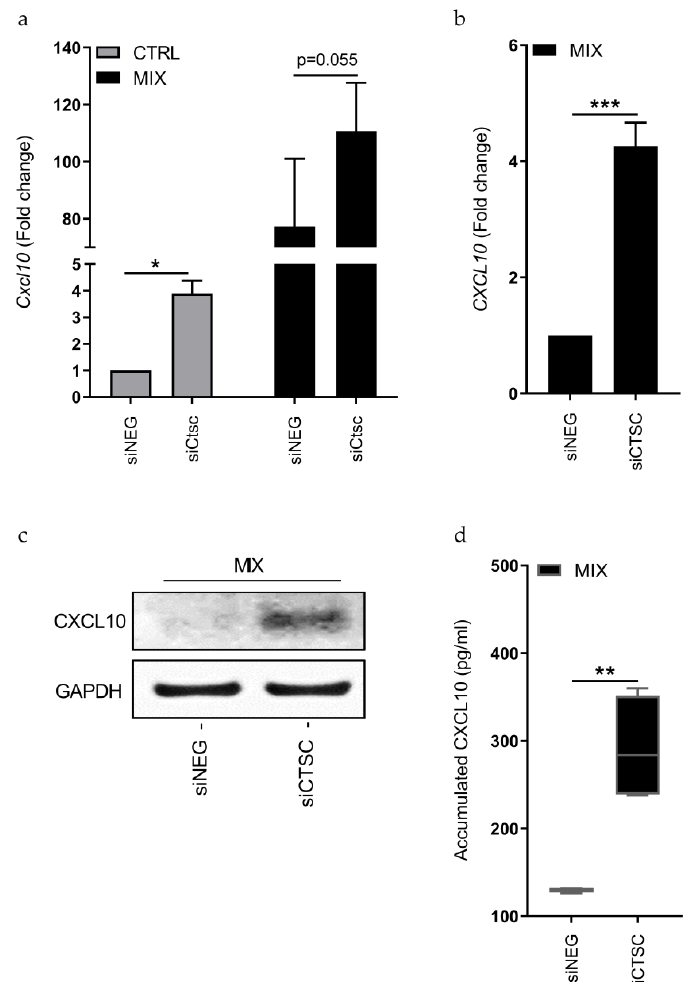
Figure 5. Knockdown of CTSC increases CXCL10 expression and secretion. ( a ) INS-1E cells were transfected with a siRNA pool against Ctsc (siCtsc) or a non-targeting negative control siRNA pool (siNEG) and left untreated (CTRL) or exposed to IL- 1β and IFN - γ for 24 h (MIX). Cxcl10 mRNA expression was analyzed using real-time qPCR with Hprt as housekeep- ing gene. ( b ) 1.1B4 cells were transfected with a siRNA pool against CTSC (siCTSC) or a non-targeting negative control siRNA pool (siNEG) and left untreated (CTRL) or exposed to IL- 1β and IFN - γ for 24 h (MIX). CXCL10 mRNA expression was analyzed using real-time qPCR with GAPDH as housekeeping gene. ( c ) Protein level of CXCL10 in 1.1B4 cells treated as in ( b ) with GAPDH as loading control. ( d ) Accumulated CXCL10 in the culture media from 1.1B4 cells treated as in ( b ). Graphs are presented as fold change with mean and SEM or pg/mL with median and 5/95 percentiles ( n = 4), ( a ) Bonferroni-adjusted * p < 0.05, ( b , d ) ** p < 0.01, *** p < 0.001.